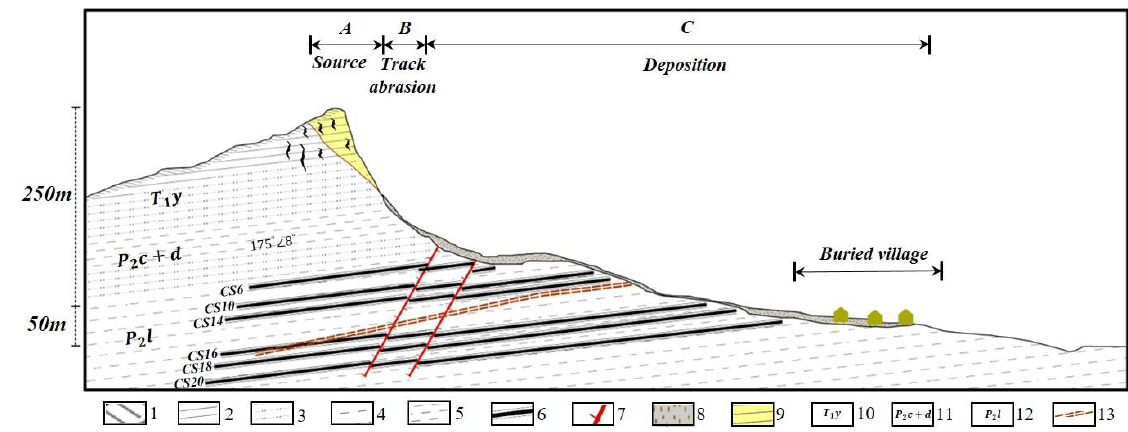
Figure 3. The geological profile of the Pusa landslide along line L-L’ in Figure 2a. 1 Quaternary deposits; 2 Sandstone; 3 Mudstone; 4 Silty_mudstone; 5 Limestone; 6 Coal seam; 7 Fault; 8 Avalanche accumulation; 9 Source area; 10 Yelang Formation of the Lower Triassic; 11 Changxing–Dalong Formation of the Upper Permian; 12 Longtan Formation of the Upper Permian; 13 Coal mine tunnel.